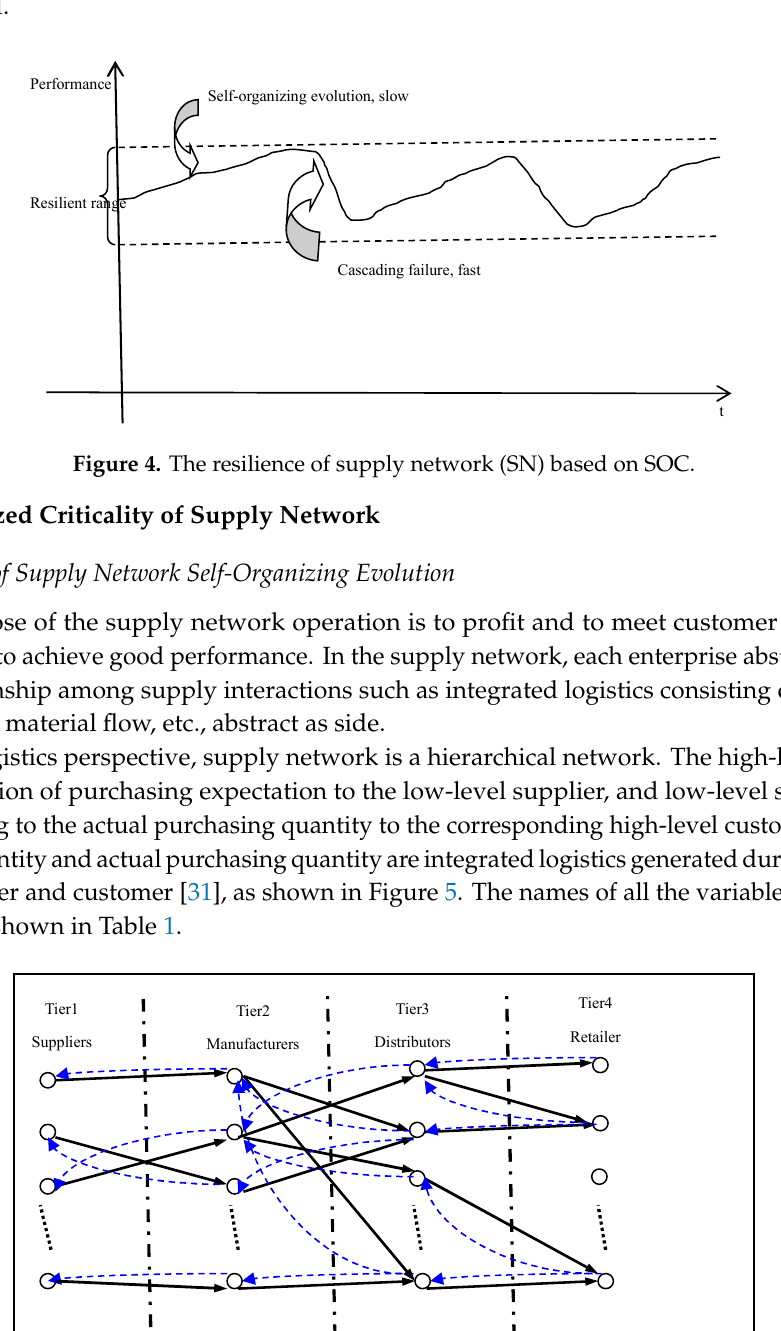
Table 1. Parameters for supply network.